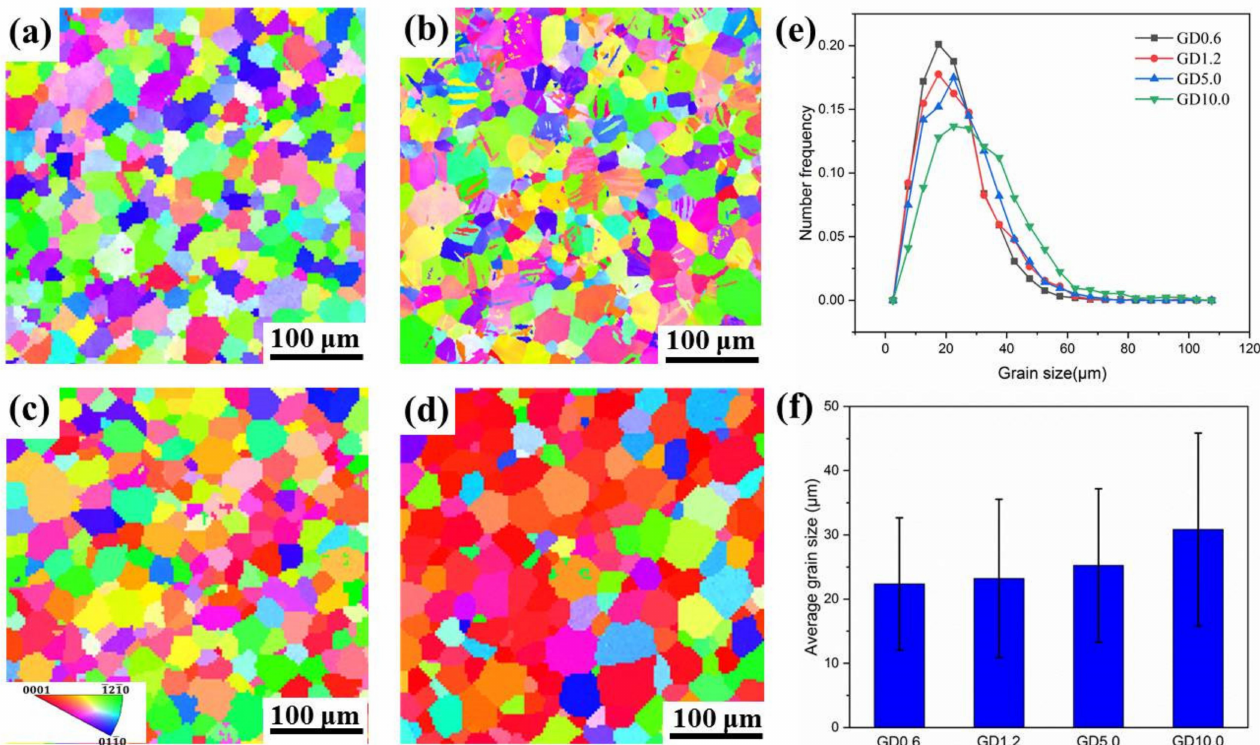
Figure 2. EBSD inverse pole figure maps perpendicular to the direction of extrusion for ( a ) GD0.6, ( b ) GD1.2, ( c ) GD5.0, and ( d ) GD10.0; ( e ) grain size distribution; and ( f ) variation of average